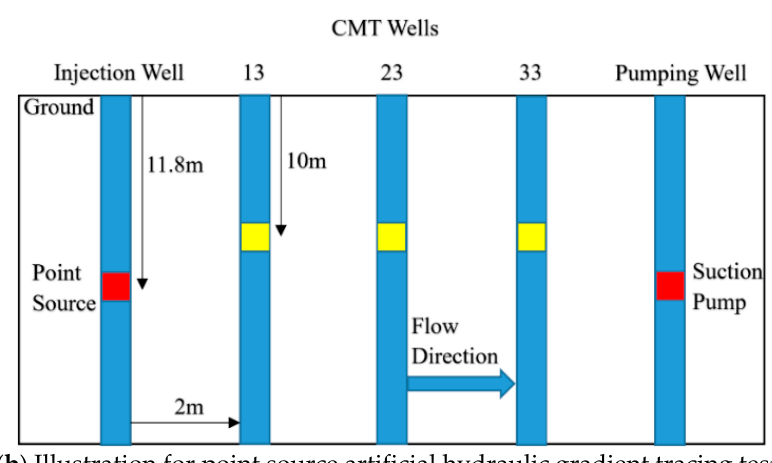
Figure 8. Study site map showing injection well, pumping well, and continuous multichannel tubing (CMT) wells.